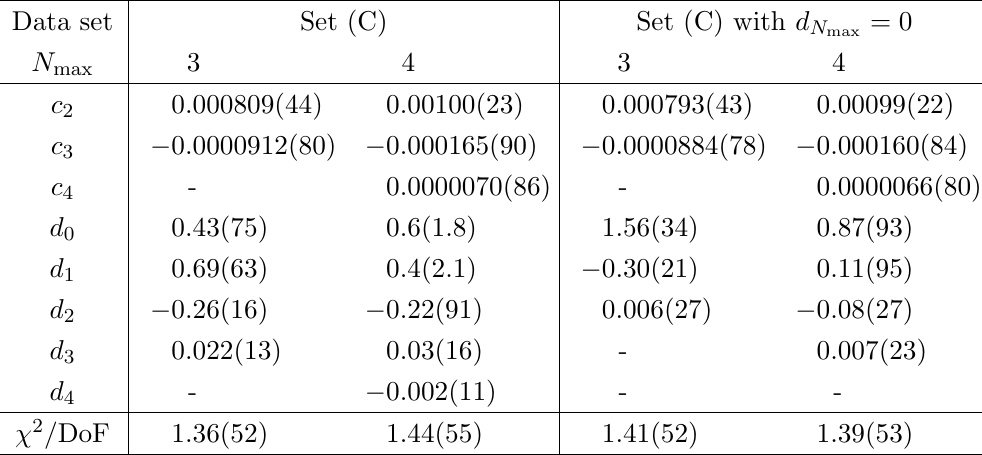
Table 4 . Fit results with the set (C) for the discrete beta